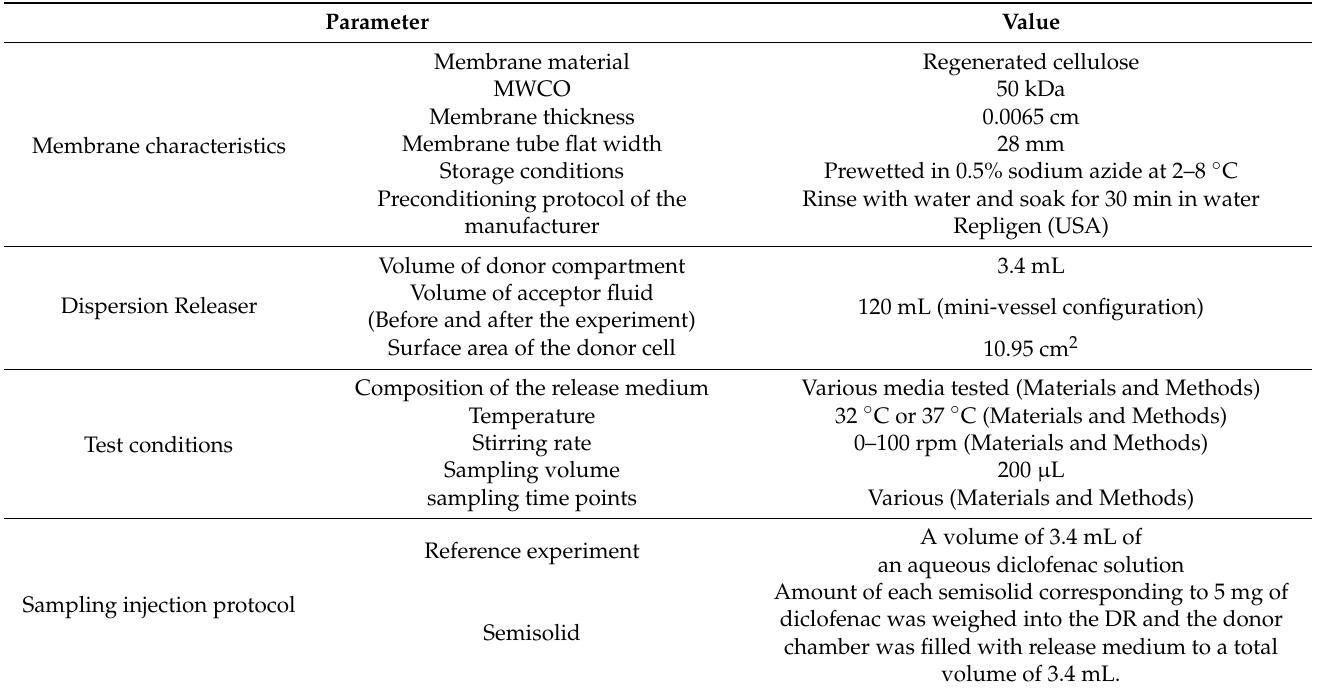
Table 4. Important experimental parameters to be reported.